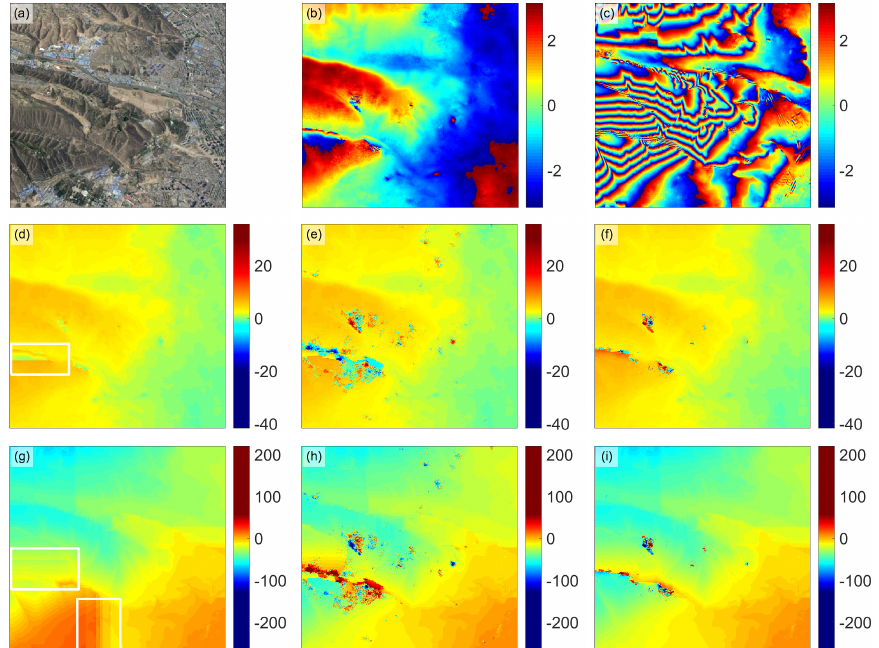
Figure 5. ( a ) Google Earth image of the study area. ( b , c ) TerraSAR-X interferograms with ( b ) short, and ( c ) long baseline lengths. ( d – f ) PU results of ( b ) obtained by ( d ) SB L 1 -norm, ( e ) MB TSPA, and ( f ) MB LPM-TSPA. ( g – i ) PU results of ( c ) obtained by ( g ) SB L 1 -norm, ( h ) MB TSPA, and ( i ) MB